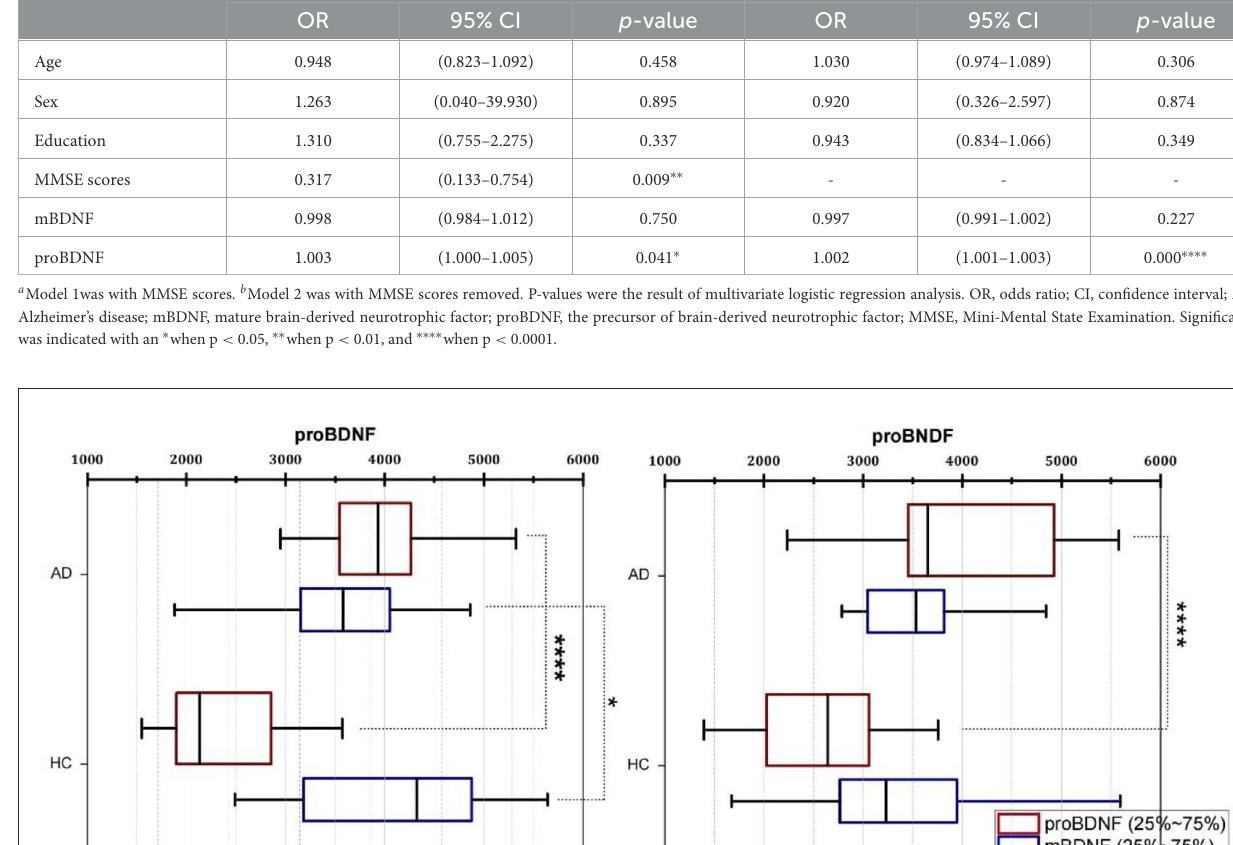
participants into four age groups: 51–60, 61–70, 71–80, and